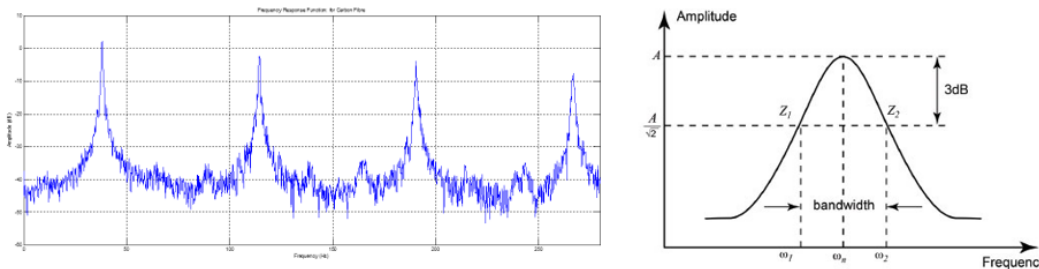
Figure 3. Typical frequency response functions of composite ( left ) and the half-power bandwidth method for loss factor calculations ( right ) proposed by Gelfuso et al. [31].